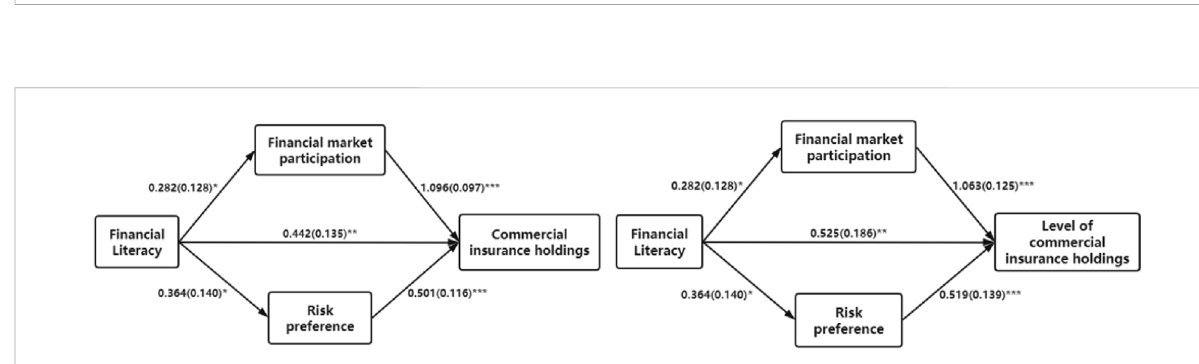
FIGURE 4 Results of the path analysis of fi nancial literacy and household commercial insurance holding